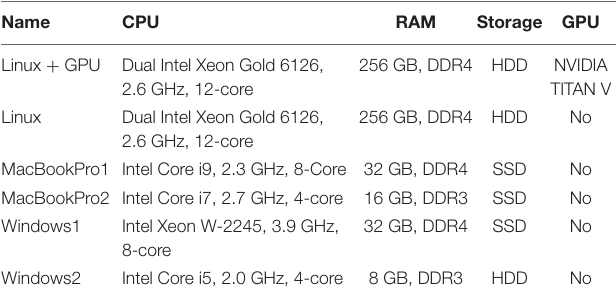
TABLE 1 | PC specifications used for the computation time